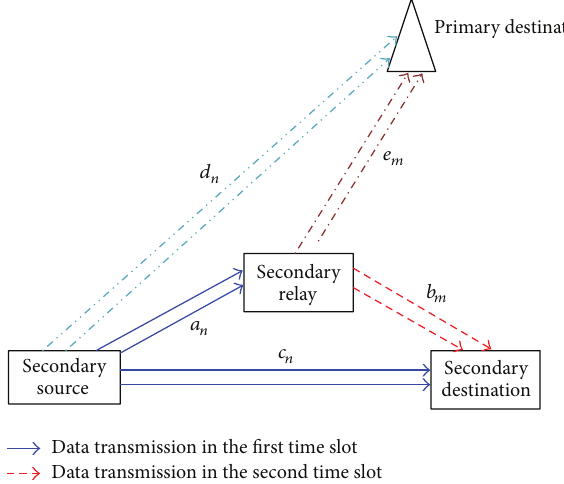
Figure 1: System